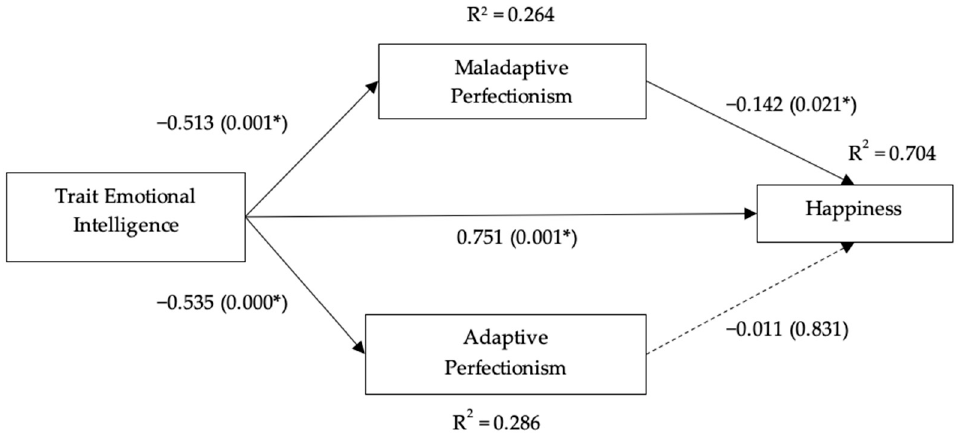
Figure 2. Summary of the path analysis findings (* for significant p -values) .